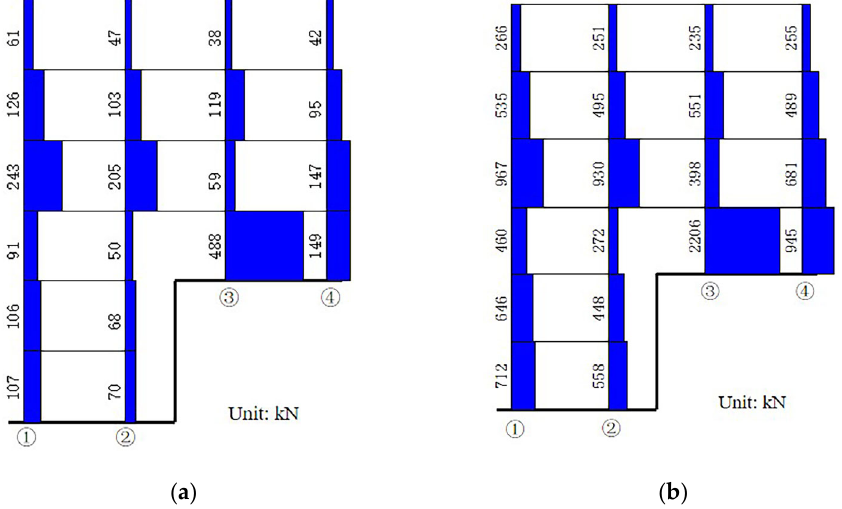
Figure 8. The column shear across the slope direction at the time of maximum base shear: ( a ) a PG, x = 0.07 g; ( b ) a PG, x = 0.62 g.